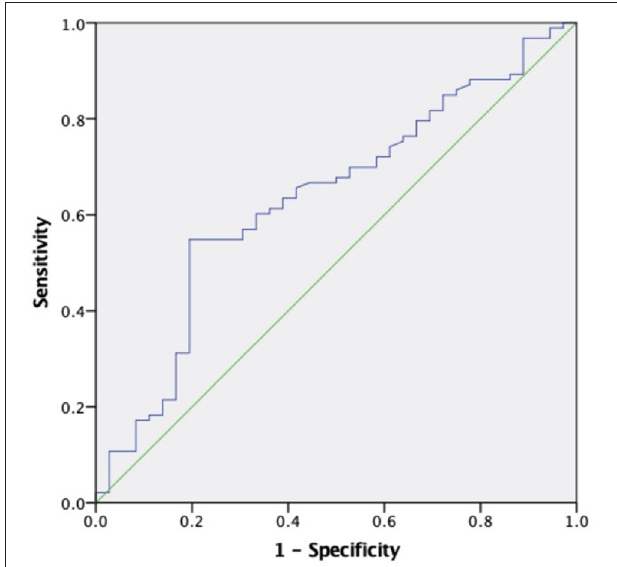
FIGURE 4 | AAC ≤ 4, relationship between soluble Klotho level and CVD mortality in MHD patients. For patients with no or mild calcification (AAC ≤ 4), the high level of soluble Klotho level (sKl > 567.8 ng/L) patients had a lower risk of CVD death than in those with low level of soluble Klotho level (sKl ≤ 567.8 ng/L). Kaplan-Meier analysis with log-rank test revealed a significant difference between groups ( P = 0.004).